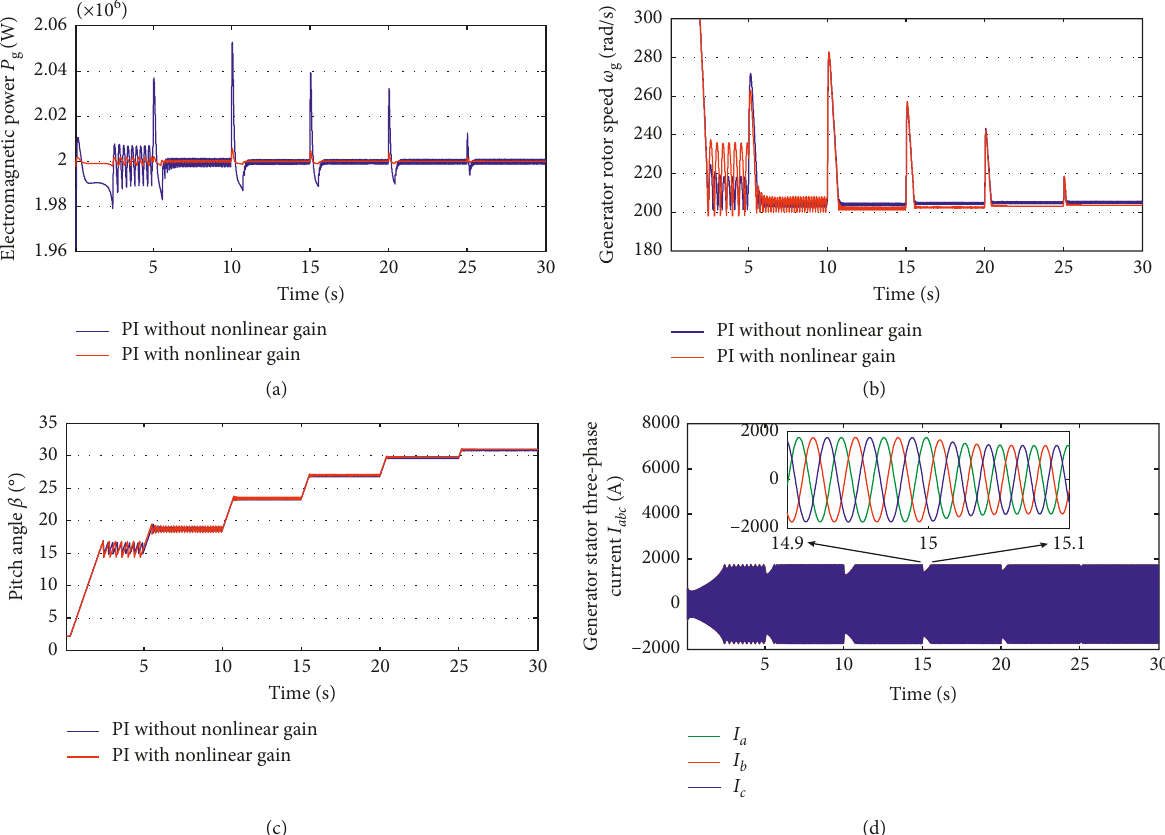
Figure 17: Responses under PI control. (a) Electromagnetic power curve. (b) Generator rotor speed curve. (c) Pitch angle curve. (d) Generator stator three-phase current under PI nonlinear gain.